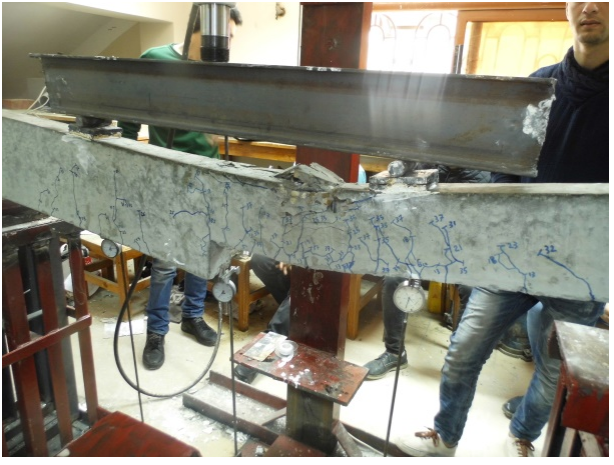
Figure 15. The crack pattern of beam B4.